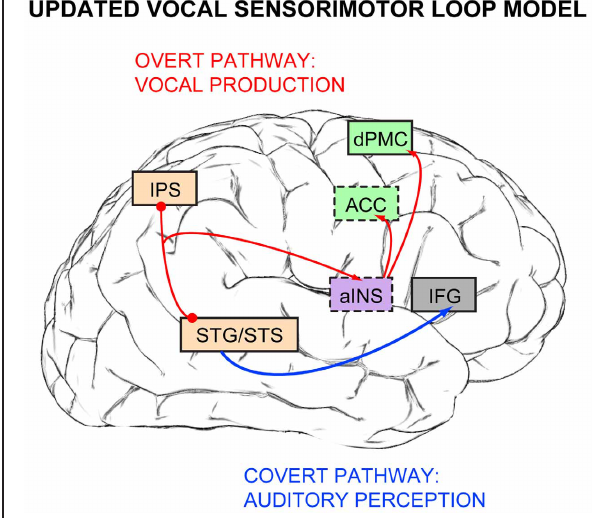
FIGURE 3 | A revised version of Berkowska and Dalla Bella’s, Dalla Bella, and colleagues’ (2009, 2011) vocal sensorimotor loop model for singing, updated with findings from Zarate and colleagues (2008, 2010b) fMRI studies. The covert pathway for pitch production (blue arrow) includes auditory cortex and inferior frontal gyrus (IFG), while the overt pathway for vocal pitch production (red arrows) is comprised of auditory cortex (STG/STS), intraparietal sulcus (IPS), anterior insula (aINS), anterior cingulate cortex (ACC), and dorsal premotor cortex (dPMC). Brain regions that are not visible normally from this lateral brain view are indicated in boxes outlined with dashes. Box colors are retained from Figure 1 : light orange for auditory processing, green for vocal motor control, purple for multimodal processing.